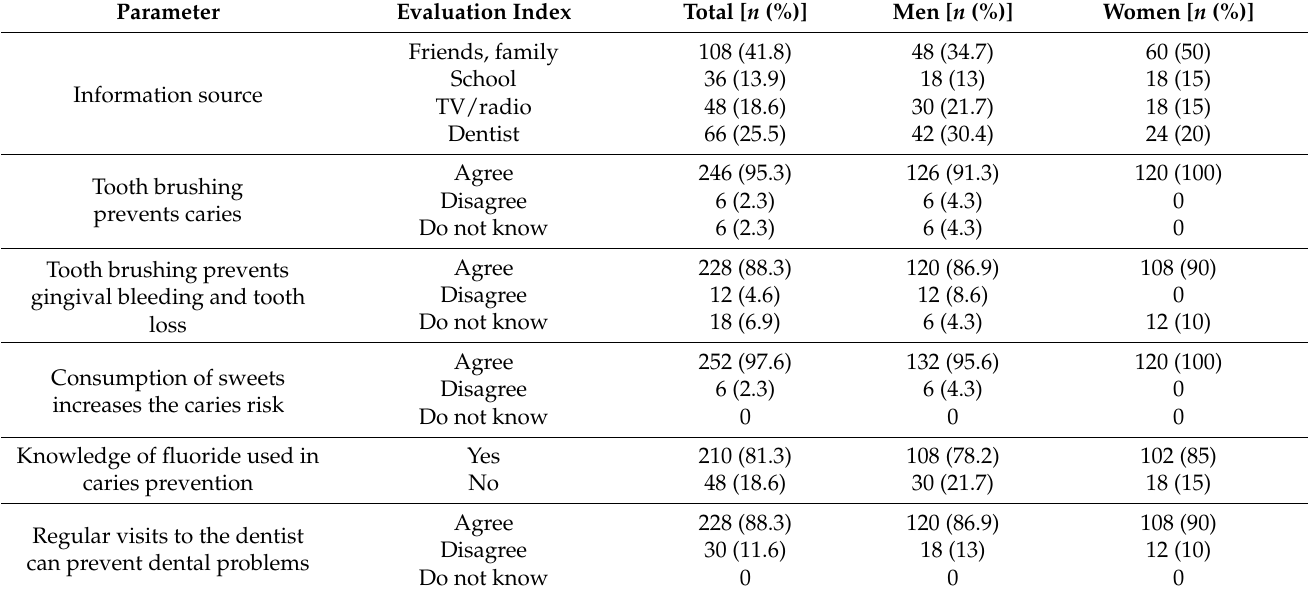
Table 2. Oral health knowledge.